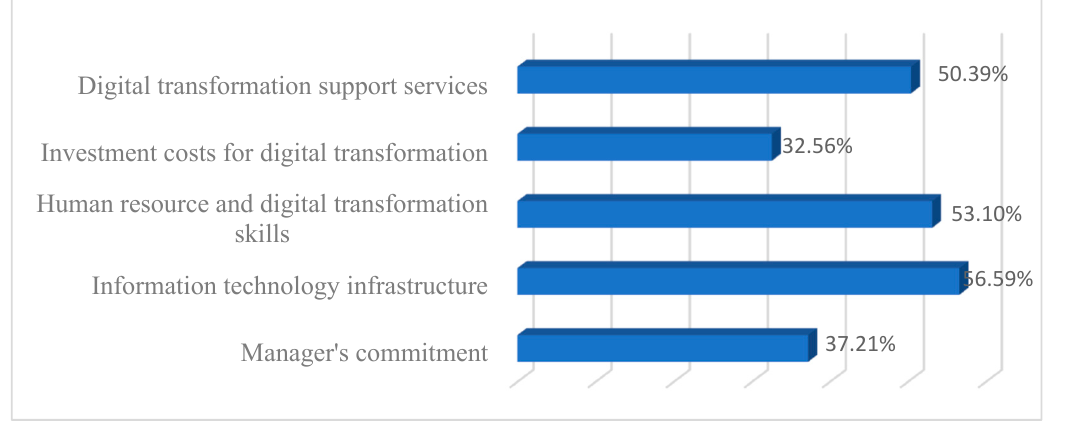
Figure 4. Degree of willingness to change to digital transformation.